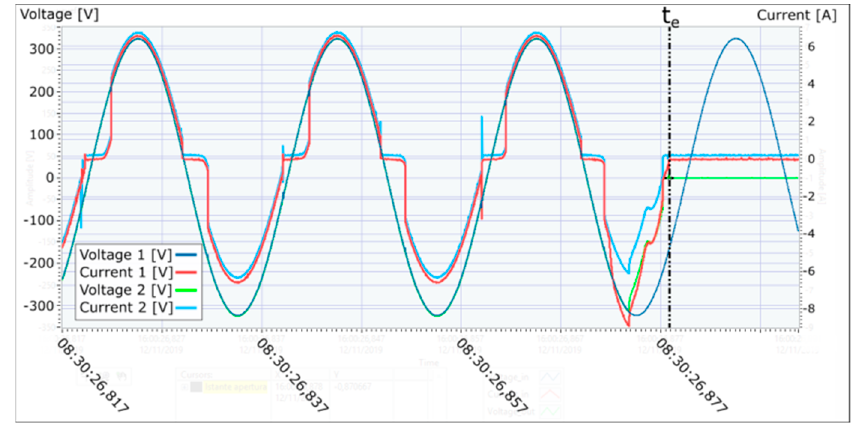
Figure 14. Instant ( t e ) at which the circuit was opened by the AFDD (using the Bourns 2049-14 surge arrester).